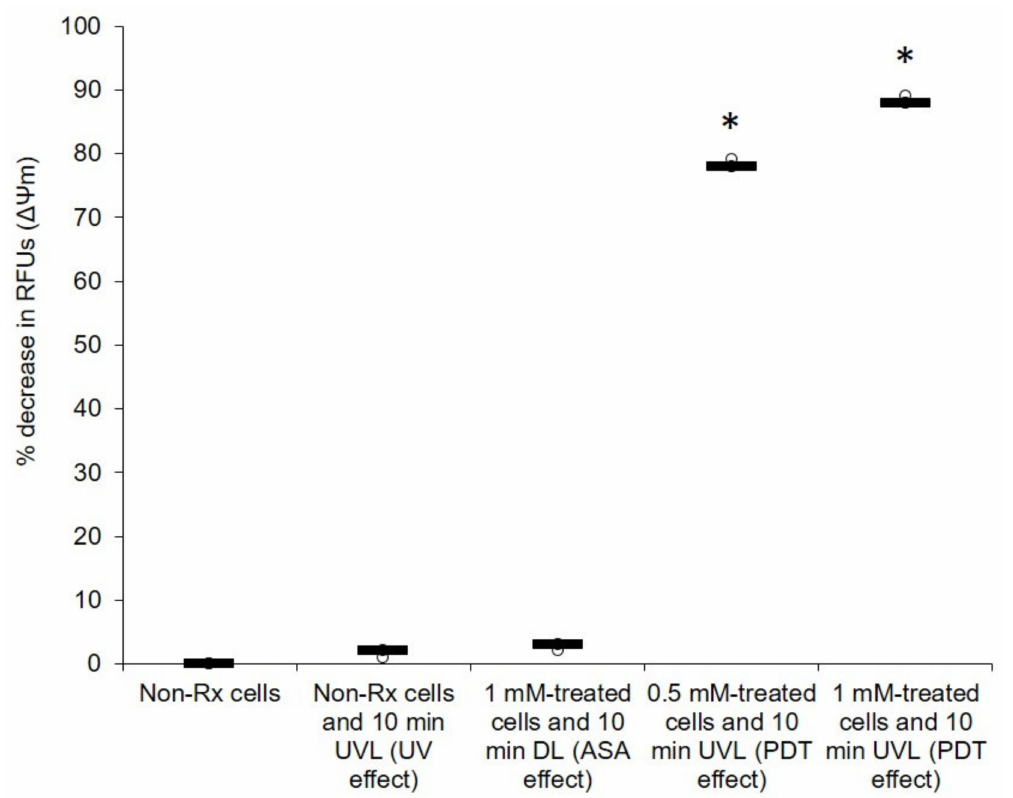
Figure 6. PDT action of ASA impairs the energising of mitochondrial membranes of C. neoformans LMPE 046 cells. The background signal of negative controls was used for normalisation. There was a normality of data distribution. Non-Rx, non-treated cells; UVL, ultraviolet light; DL, dark light; RFUs, relative fluorescence units. Data points were obtained from three biological replicates for each defined experimental condition. * Significantly different from non-Rx cells at p <